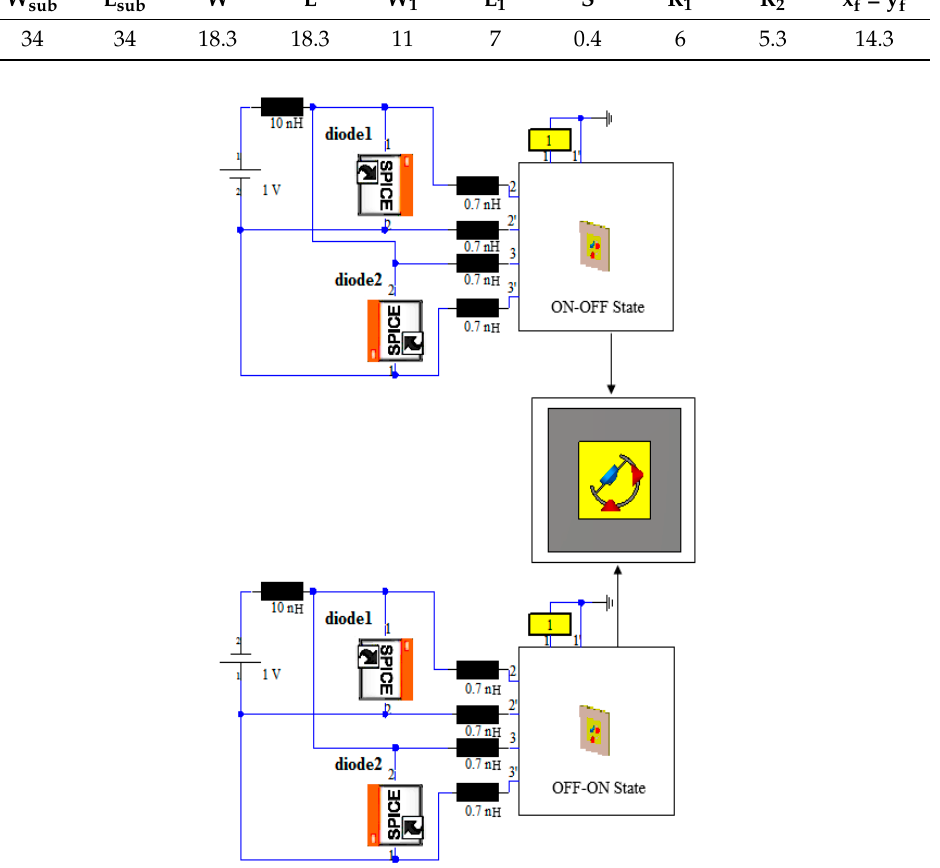
Figure 2. A hybrid EM-circuit co-simulation of the antenna.